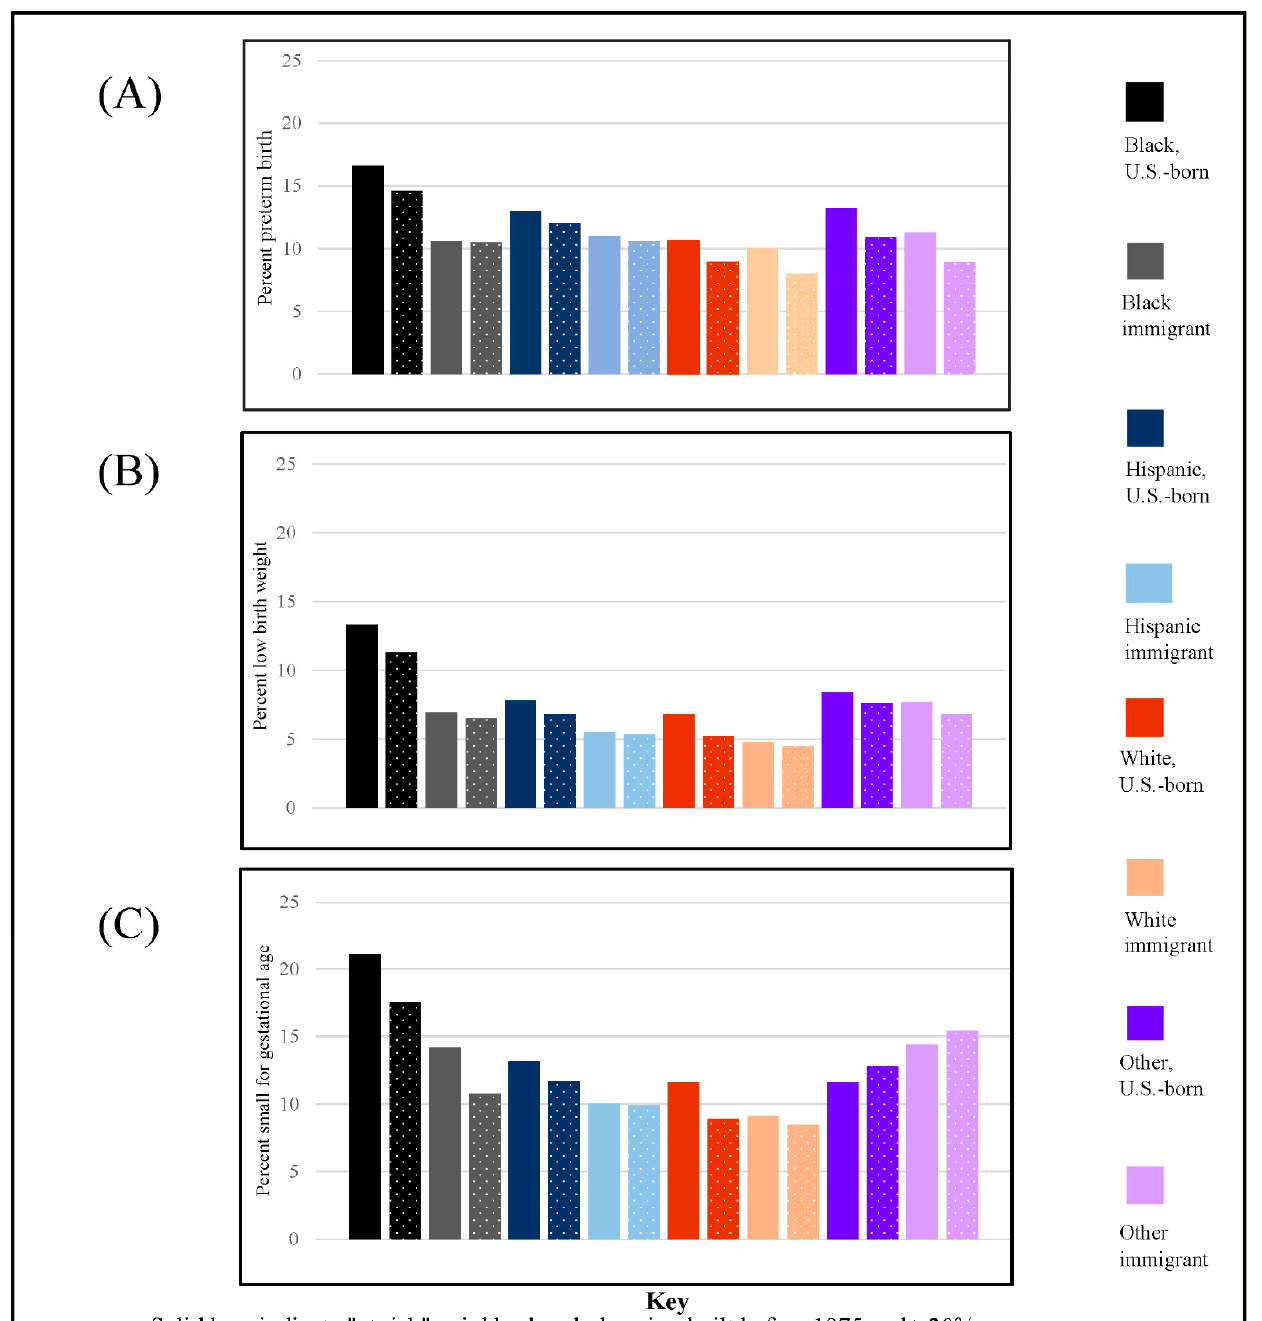
Figure 2. Percent preterm birth (graph A ), low birth weight (graph B ), and small-for-gestational age (graph C ) by race/ethnicity/nativity and risk status, 2009–2011 Texas natality files, n = 1,040,642. Sources: American Community Survey, 2007–2011, and birth certificate data from the Texas Depart- ment of State Health Services, 2009–2011.